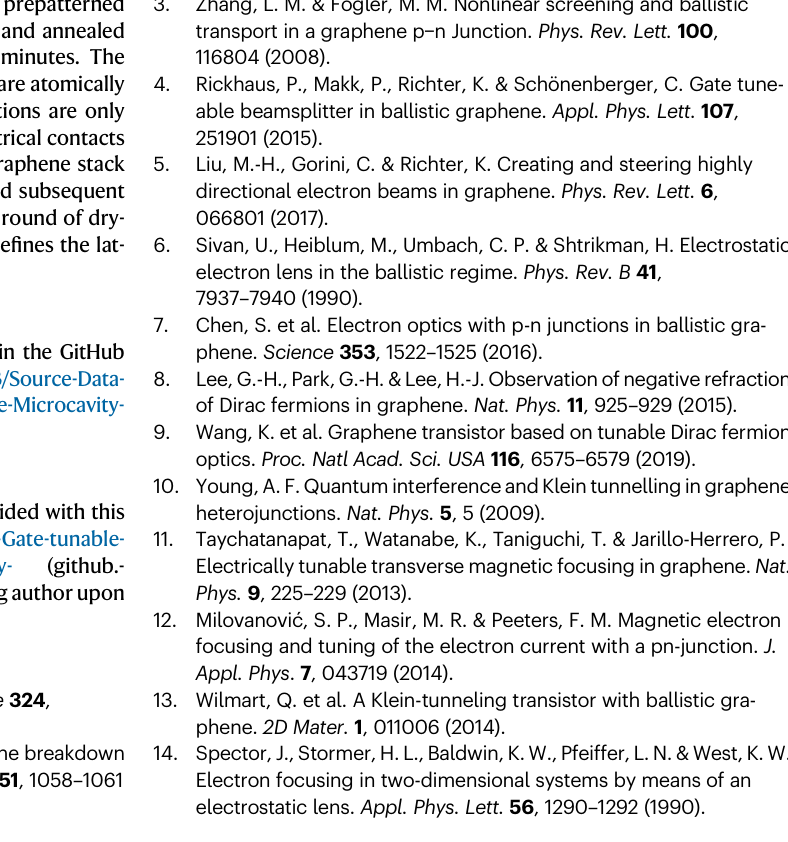
leads to d a near-zero measured transverse voltage at 4| n 1 |=| n 2 | in the midst of high resistance background. c When | n 1 | ≥ | n 2 |, the collimation ef fi ciency is not character- ized by transverse voltages. e Weak bias dependence is observed for the zero trans- verse resistance dip. f As a perpendicular magnetic fi eld is applied beyond 0.3 T, the measured transverse voltage increases both due to the destruction of Veselago interference. g Nosigni fi canttemperaturedependenceisrecordedfrom T